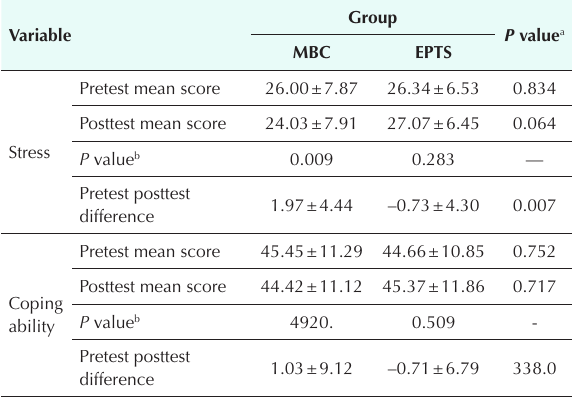
Table 2 . Between- and within-group comparisons in terms of the mean scores of stress and coping ability